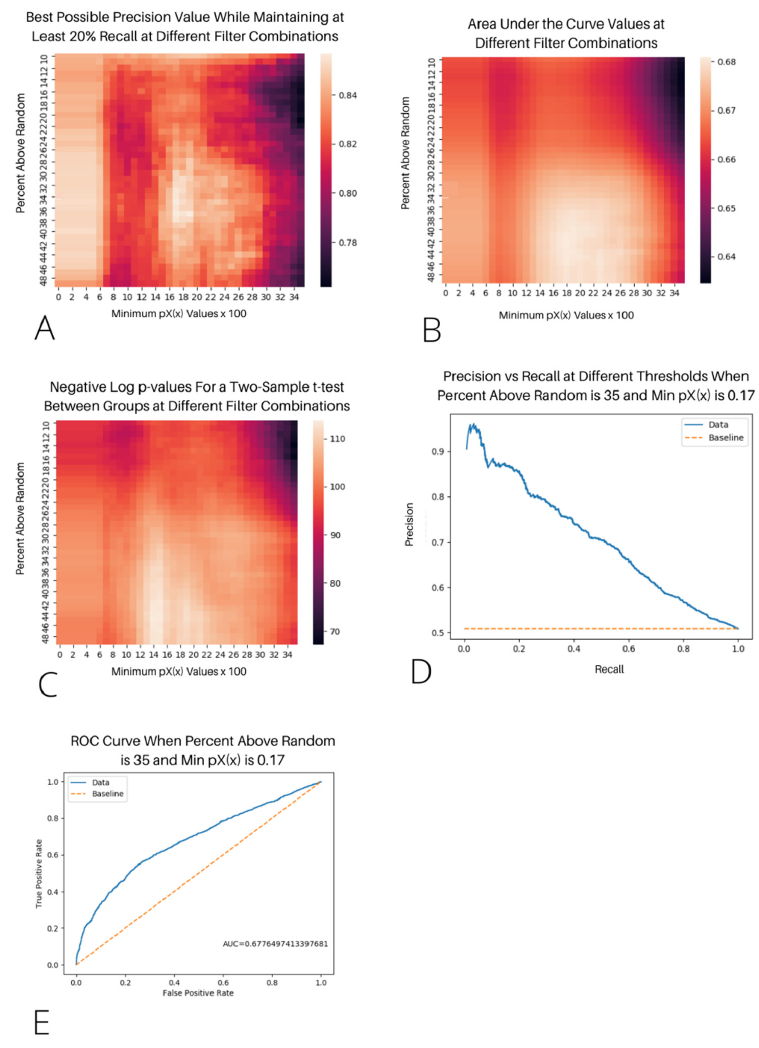
Figure 1. The results of different statistical tests when comparing protein pairs that are known to interact versus those that have not been proven to interact to show trends in the data for the vertebrate dataset. ( A ) A heatmap of the best possible precision scores obtained by comparing the known-to-interact and unproven-to-interact scores for each filter combination while still maintaining a recall of at least 20%. ( B ) A heatmap of the values of the area under the curve from comparing the known-to-interact and unproven-to-interact scores for each filter combination. ( C ) A heatmap of the negative log of the p -values from a two-sample t -test by comparing the known-to-interact and unproven-to-interact scores for each filter combination. Note that while each combination returned a significant p -value, some combinations were more significant than others. ( D ) A graph of all precision and recall values for the results from a min p (cid:2908) (x) of 0.17 and a minimum percent above random for p (cid:2908)(cid:2909) (x,y) of 35%, which were determined to be the optimal filters due to the resulting high precisions. ( E ) The receiver operating characteristic (ROC) curve from comparing the known-to-interact and unproven-to-interact scores for each filter combination.